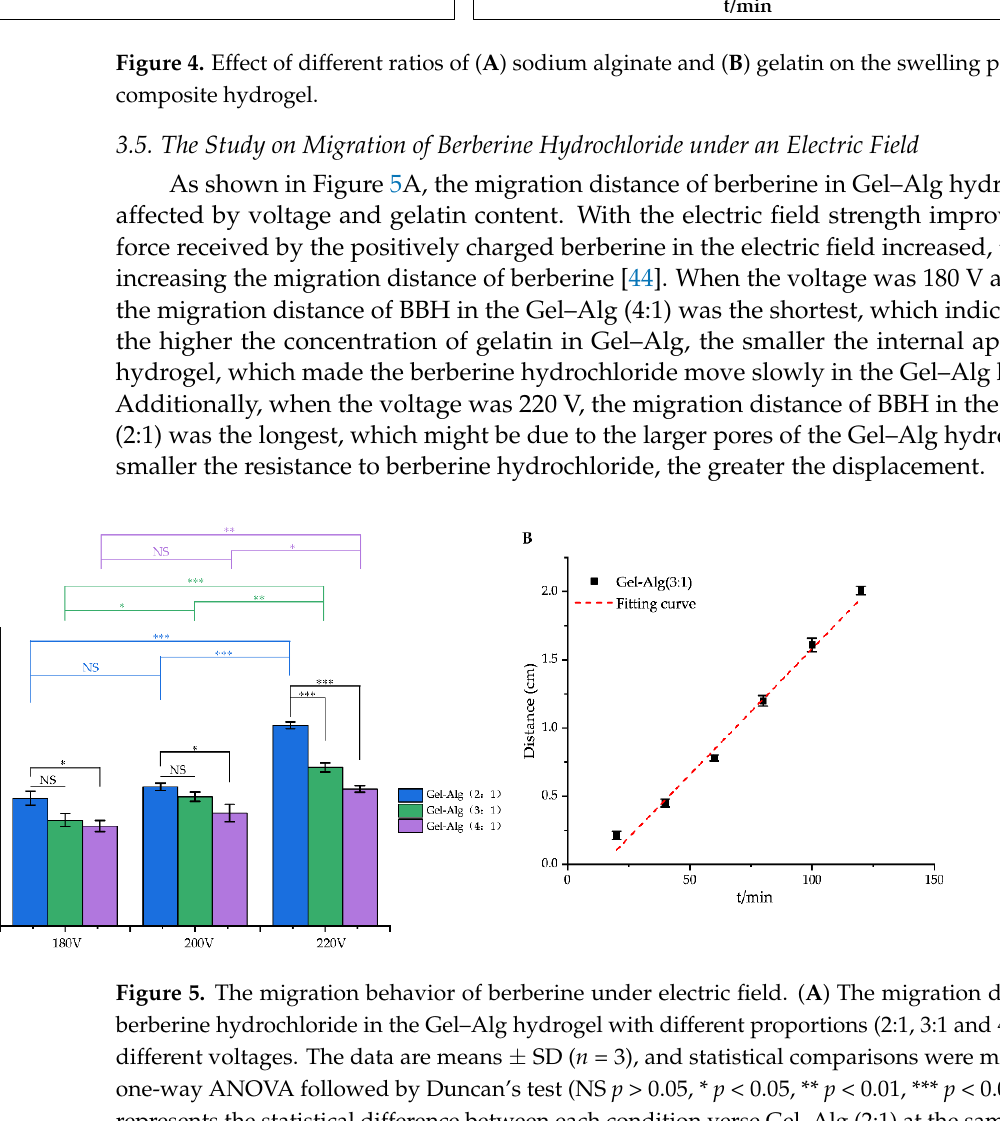
Figure 4. Effect of different ratios of ( A ) sodium alginate and ( B ) gelatin on the swelling property of composite hydrogel.